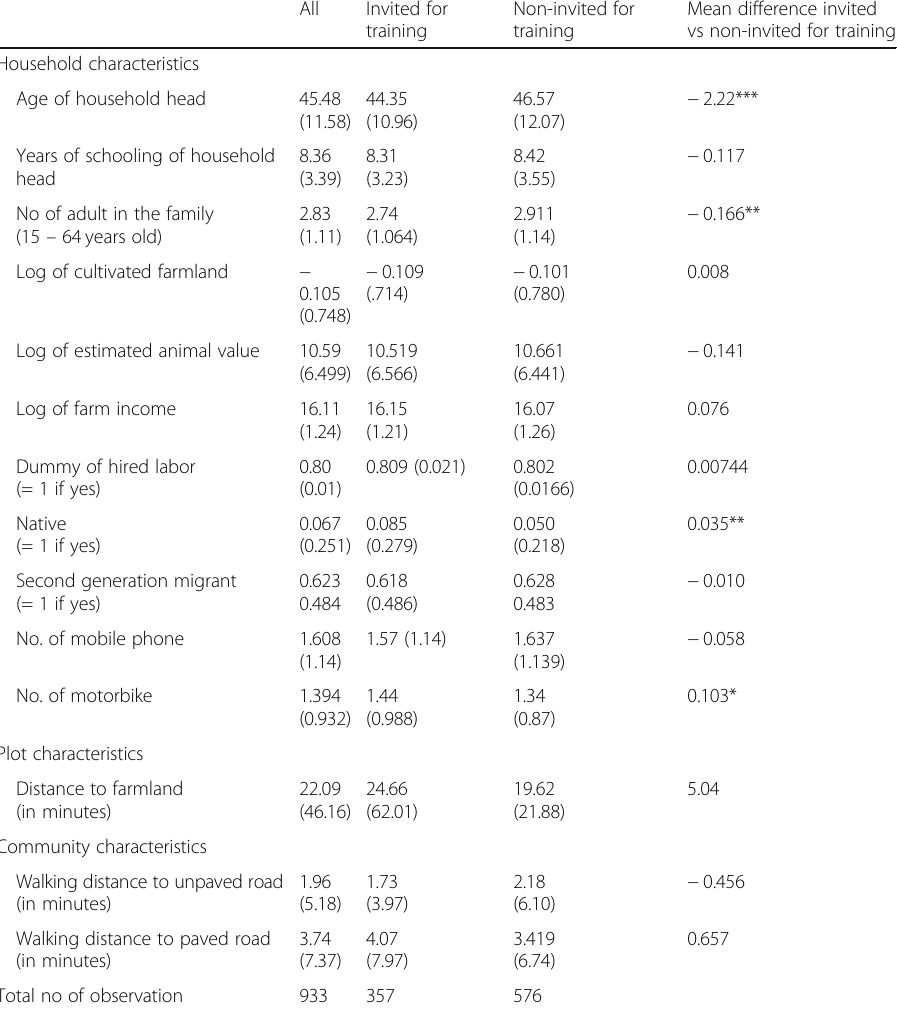
Table 2 Descriptive statistics of the invited and uninvited farmers